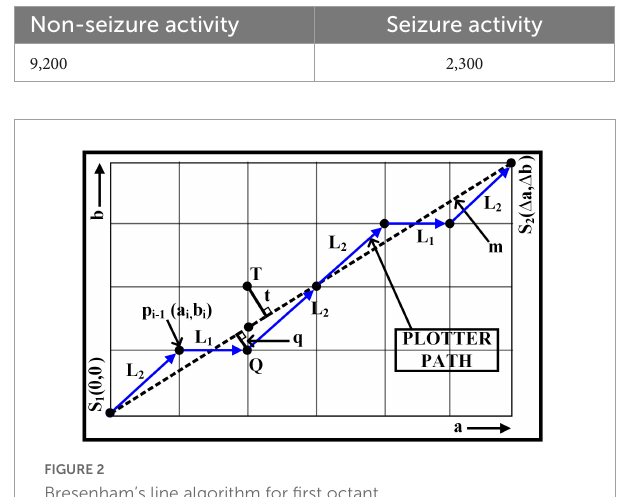
TABLE 2 Number of windows for each class in dataset 2.